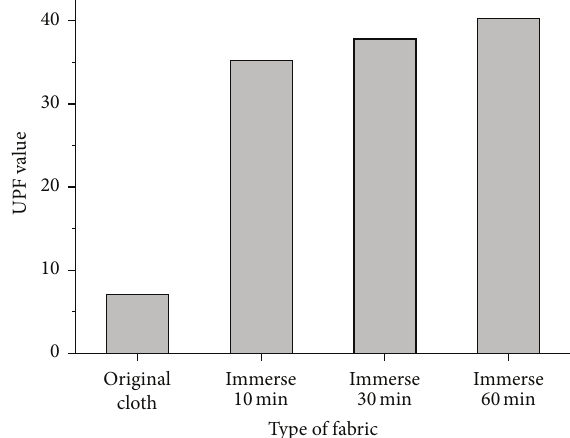
Figure 8: UPF values of nanocoated woven polyester fabric at different immersion times